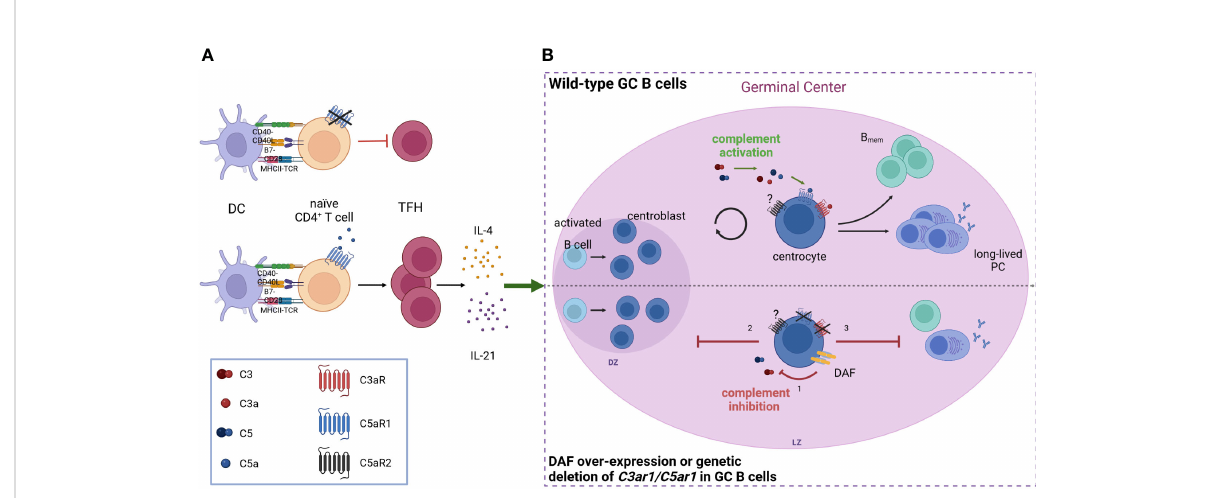
FIGURE 2 Anaphylatoxin receptor activation on TFH cells and GC B cells controls the production of IgG (auto)antibodies (A) C5aR1 signaling on CD4+ T cells facilitates the expansion of TFH cells and their subsequent production of IL-4 and IL-21, which are crucial for the germinal center reaction. The absence of C5aR1 signaling leads to an attenuated TFH cell expansion and reduced GC reaction. (B) During the GC reaction, C3a and C5a engage their receptors, C3aR and C5aR1 respectively, on GC B cells, driving B cell proliferation and differentiation into memory B cells (B mem ) as well as long-lived plasma cells (PC). When complement activation is inhibited (bottom) either by decay-accelerating factor (DAF, CD55) over- expression or deletion of C3aR/C5aR1 on GC B cells, (1) GCs collapse prematurely due to impaired dark zone re-entry and af fi nity maturation (2), resulting in decreased generation of Bmem and long-lived PCs (3). Created in